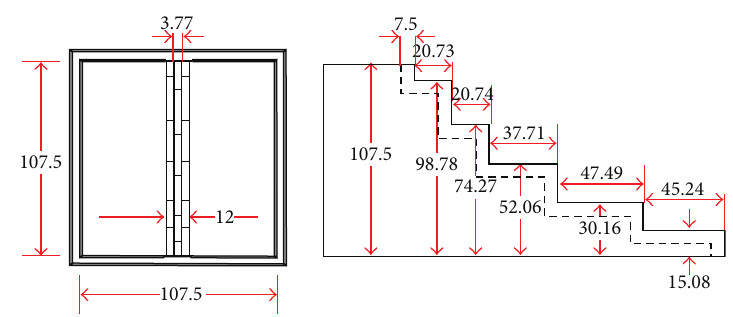
Figure 1: Geometry of three-port stepped-septum polarizer (item: mm).